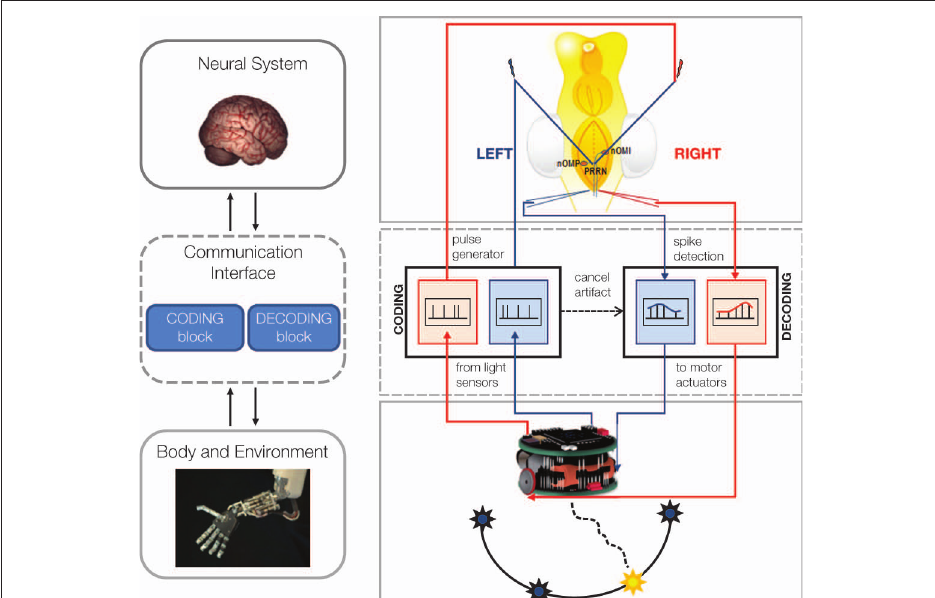
in artificial cerebro-spinal fluid within a recording chamber. Glass microelectrodes record extracellular responses to the stimuli from the posterior rhombencephalic reticular nuclei (PRRN). Recorded signals from right and left PRRNs are decoded by the interface, which generates the commands to the robot’s wheels. These commands are set to be proportional to the estimated average firing rate on the corresponding side of the lamprey’s brainstem. The robot is placed in a circular arena with light sources on the periphery. The neural system between stimulation and recording electrodes determines the motions in response to each light source (modified from Mussa-Ivaldi and Miller,